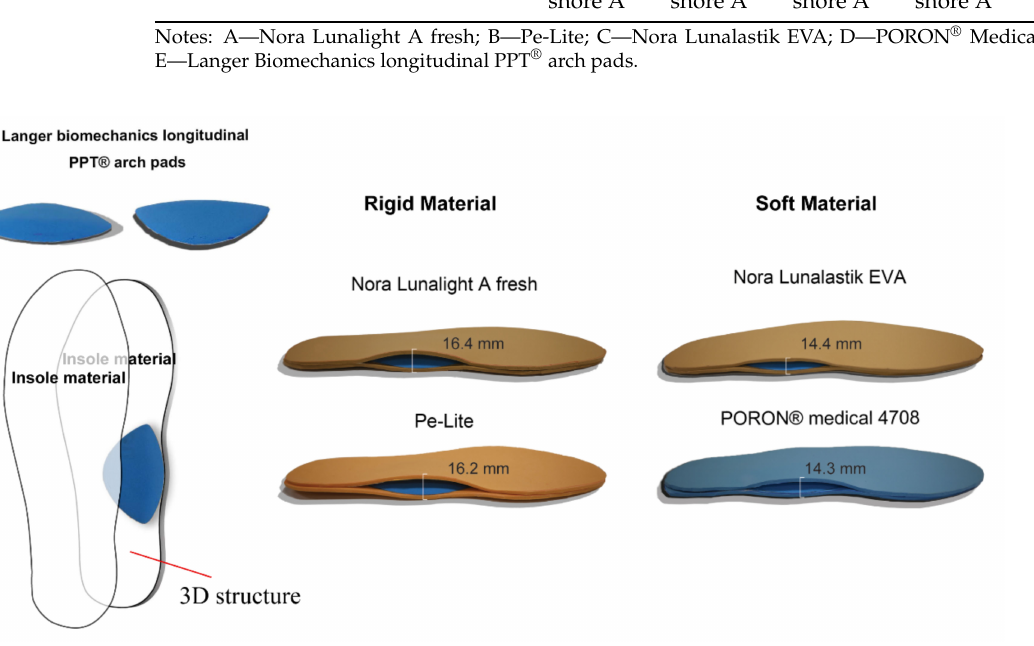
Figure 1. Contoured 3D insole structures with different